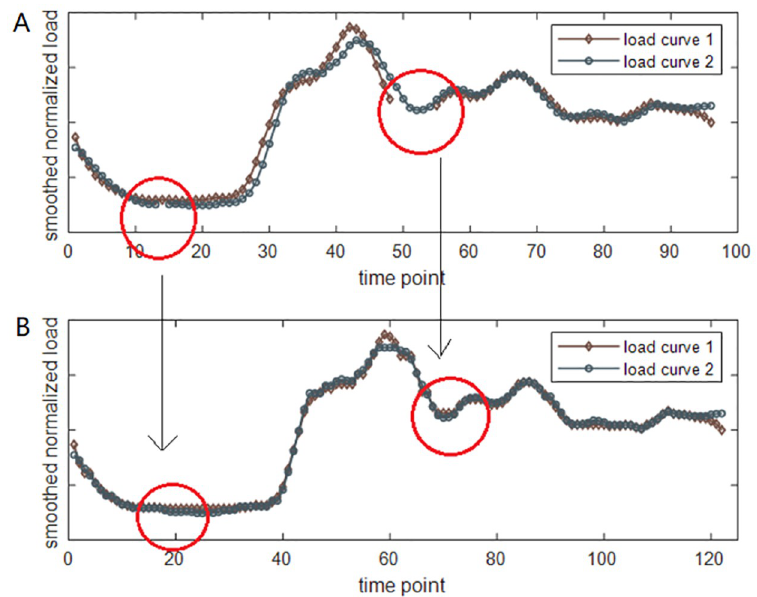
Fig 6. The applications of DTW on load curves with missing values. (A) The red cycles highlight the missing values in raw data. (B) The missing values are repaired by dsDTW.